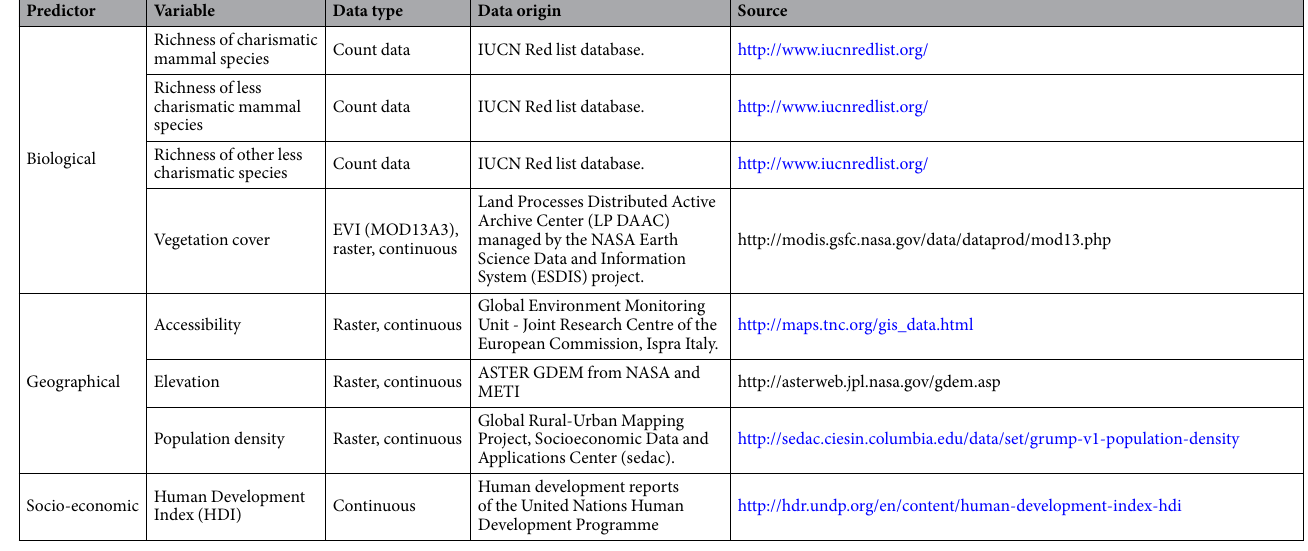
Table 2. Potential predictors used in the GLM to explain social media use by tourists visiting sub-Saharan Africa’s